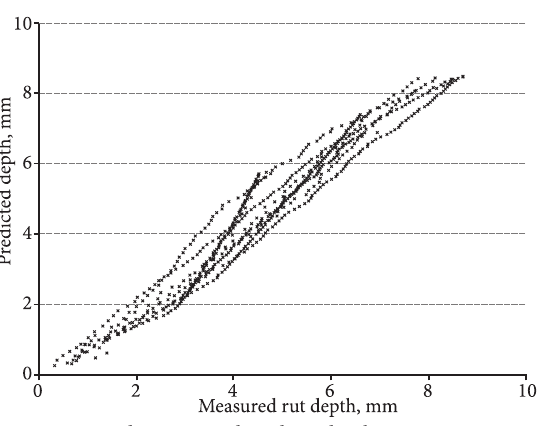
Fig. 9. Measured versus predicted rut